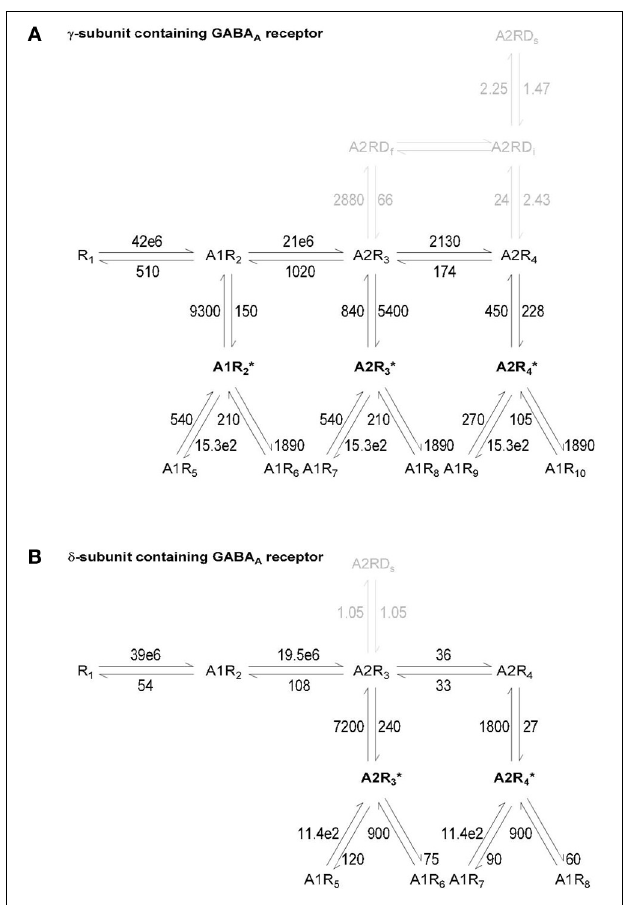
FIGURE 2 | Kinetic model of γ - and δ -subunit containing GABA A receptors. The kinetic models of γ - subunit containing GABA A receptors (A) and δ -subunit containing GABA A receptors (B) correspond to the ones developed by Haas and Macdonald (1999) and were corrected for a Q 10 = 3 (Gonzales et al., 2007). Agonist molecules are indicated by A, resting states of the receptor by R, desensitized states by D and open states by an asterisk. D f , D i and D s represent the fast, intermediate and slow desensitized states of γ -subunit containing GABA A receptors. The δ - subunit containing GABA A receptors only have a D s state. The units for all rate constant are s − 1 except for GABA binding states, which are expressed in M − 1 s − 1